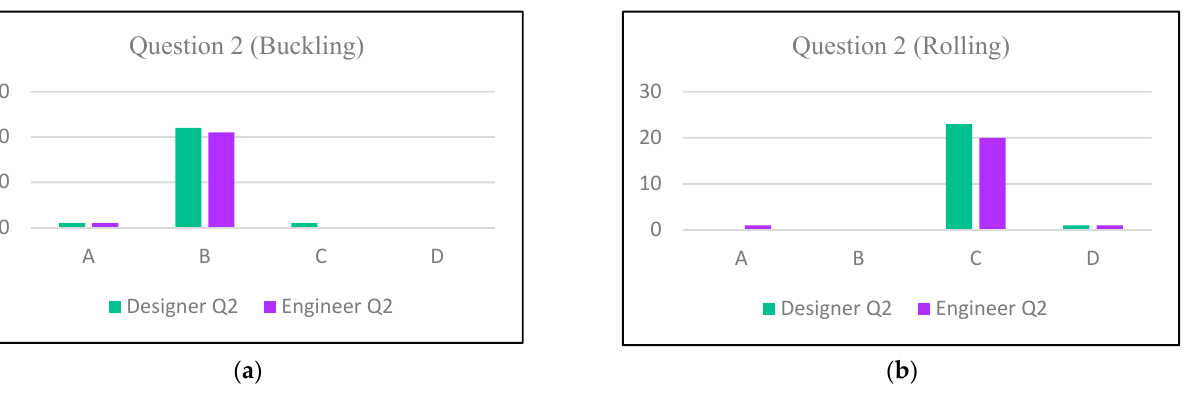
Figure 8. ( a ). Results from (Insertion task-Question2—Buckling) ( b ). Results from (Insertion task-